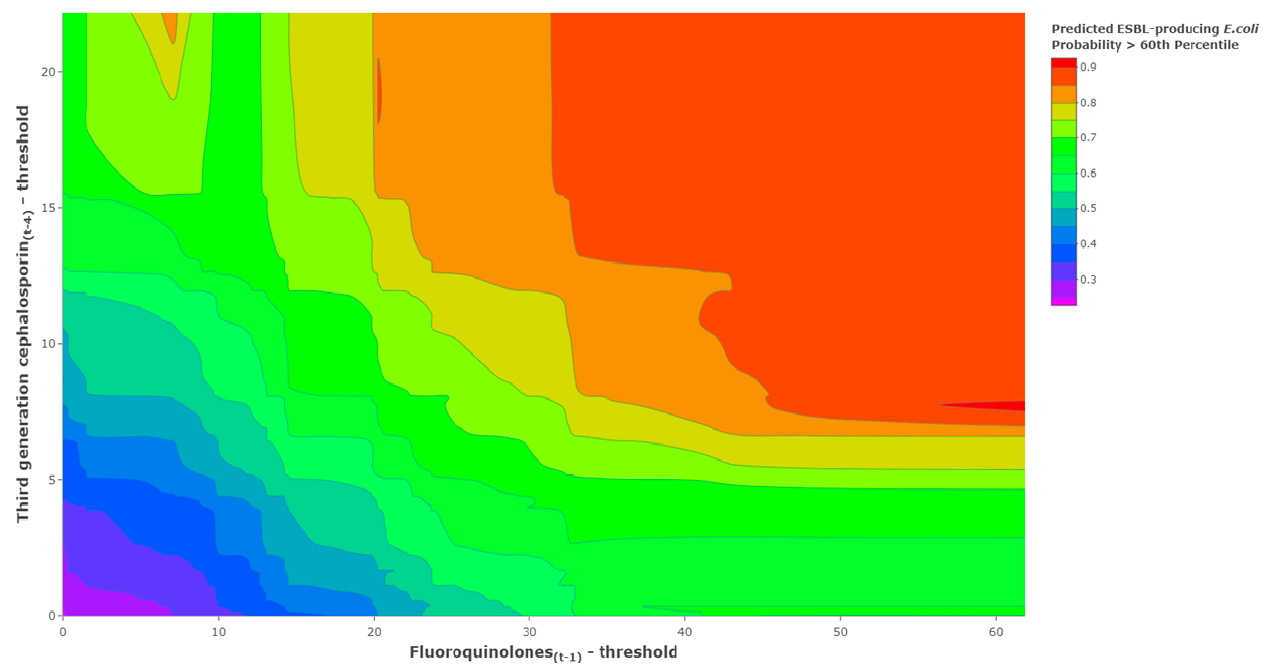
Figure 6. Results of triangulating antibiotic unit changes above identified threshold levels and the predicted probability of exceeding the 60th percentile of historical ESBL-producing E. coli using the identified threshold logistic model.